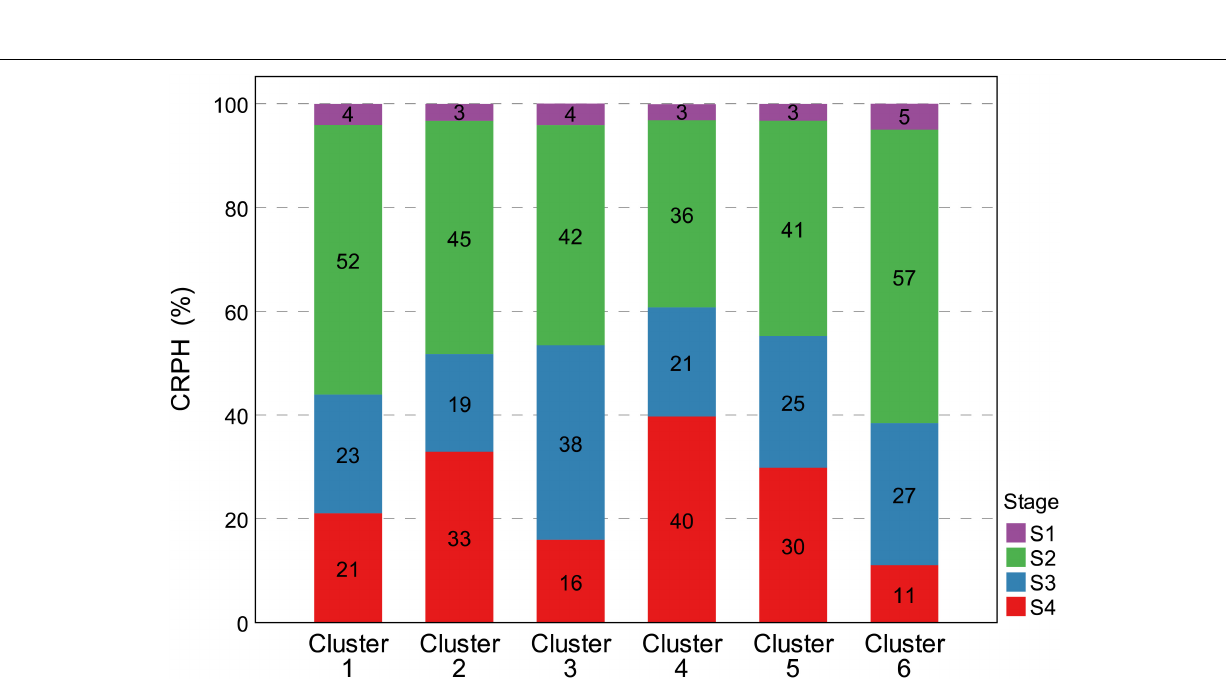
Frontiers in Plant Science |